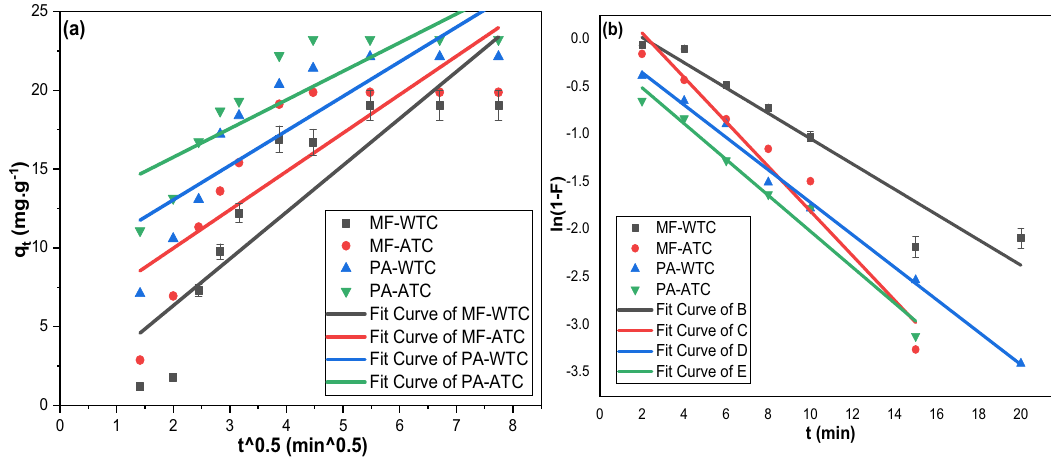
Figure 4. ( a ) IPDM, and ( b ) LFDM fittings for the adsorption of MF and PA on WTC and ATC.